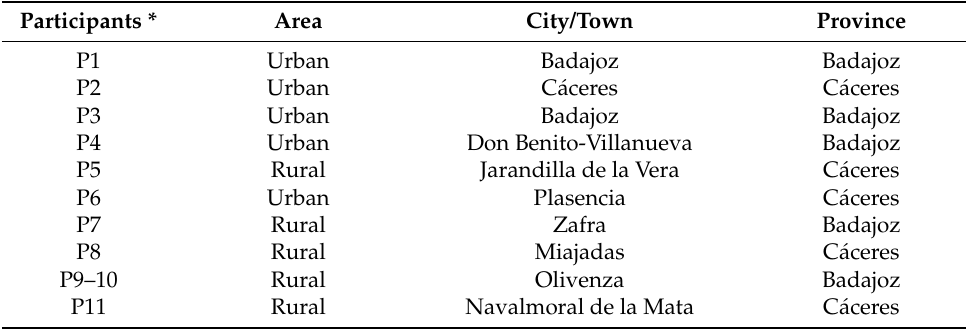
Table 1. Participants’